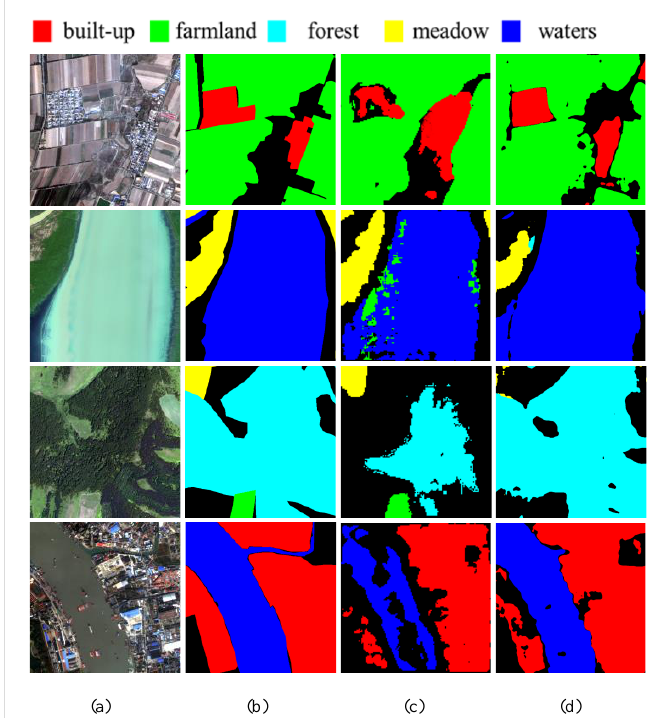
Figure 7. Representative cases of image segmentation results with SegNet and NAS-HRIS,